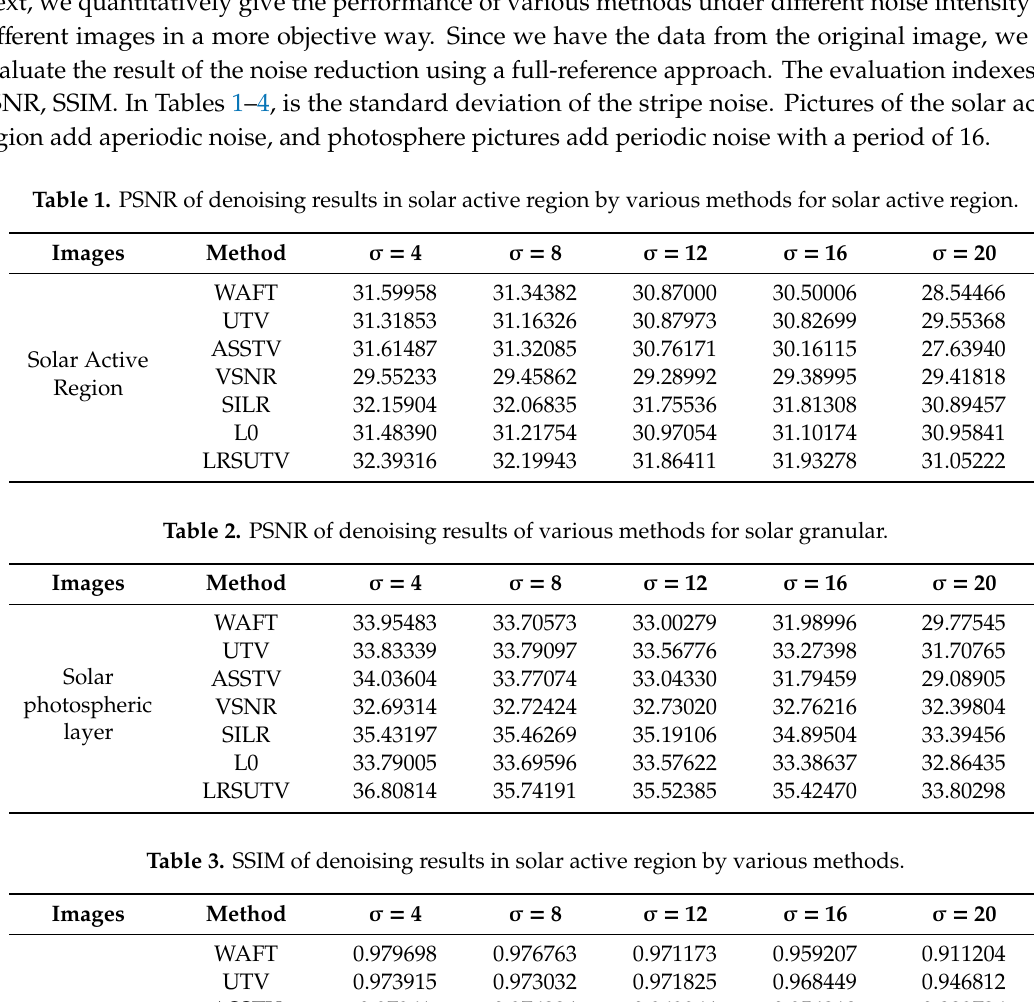
Table 3. SSIM of denoising results in solar active region by various methods. Images